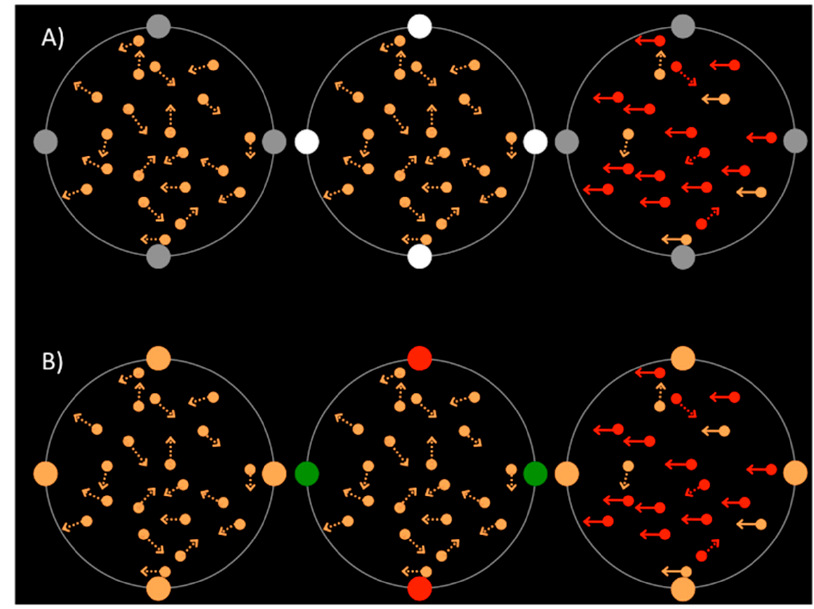
Figure 1. Schematic illustrations of ( A ) luminance and ( B ) color cues. Four dots were present throughout the trial as on the left and right rows, and changed in luminance or color during the cue period, as shown in the center row.